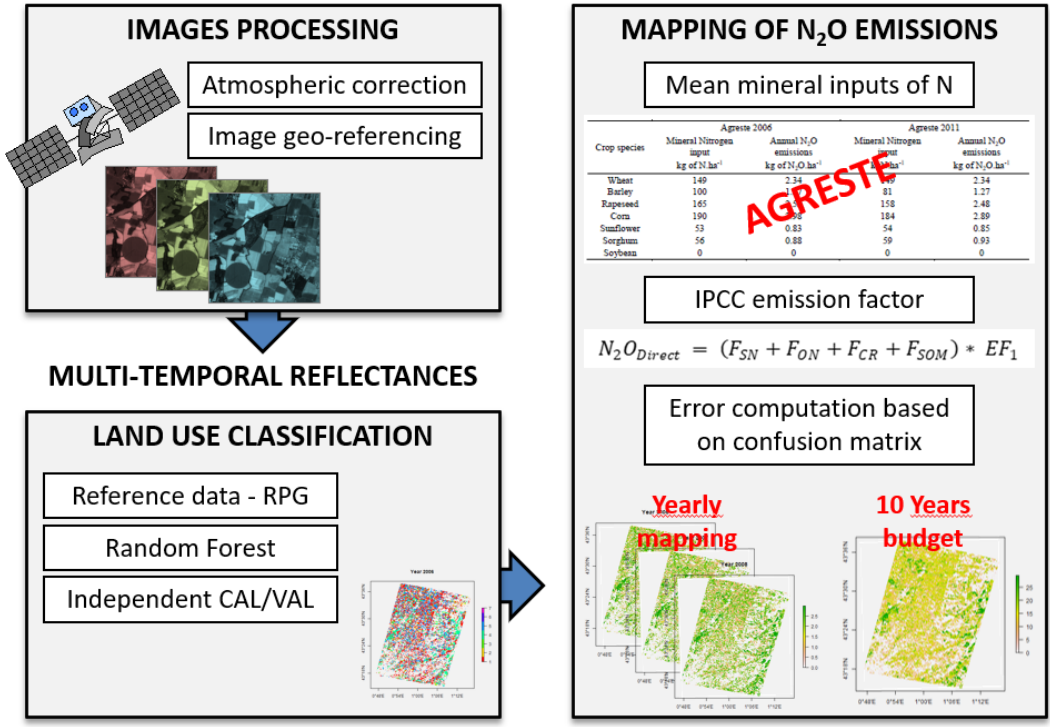
Figure 3. Synopsis of the successive steps involved to estimate potential emissions of N 2 O.